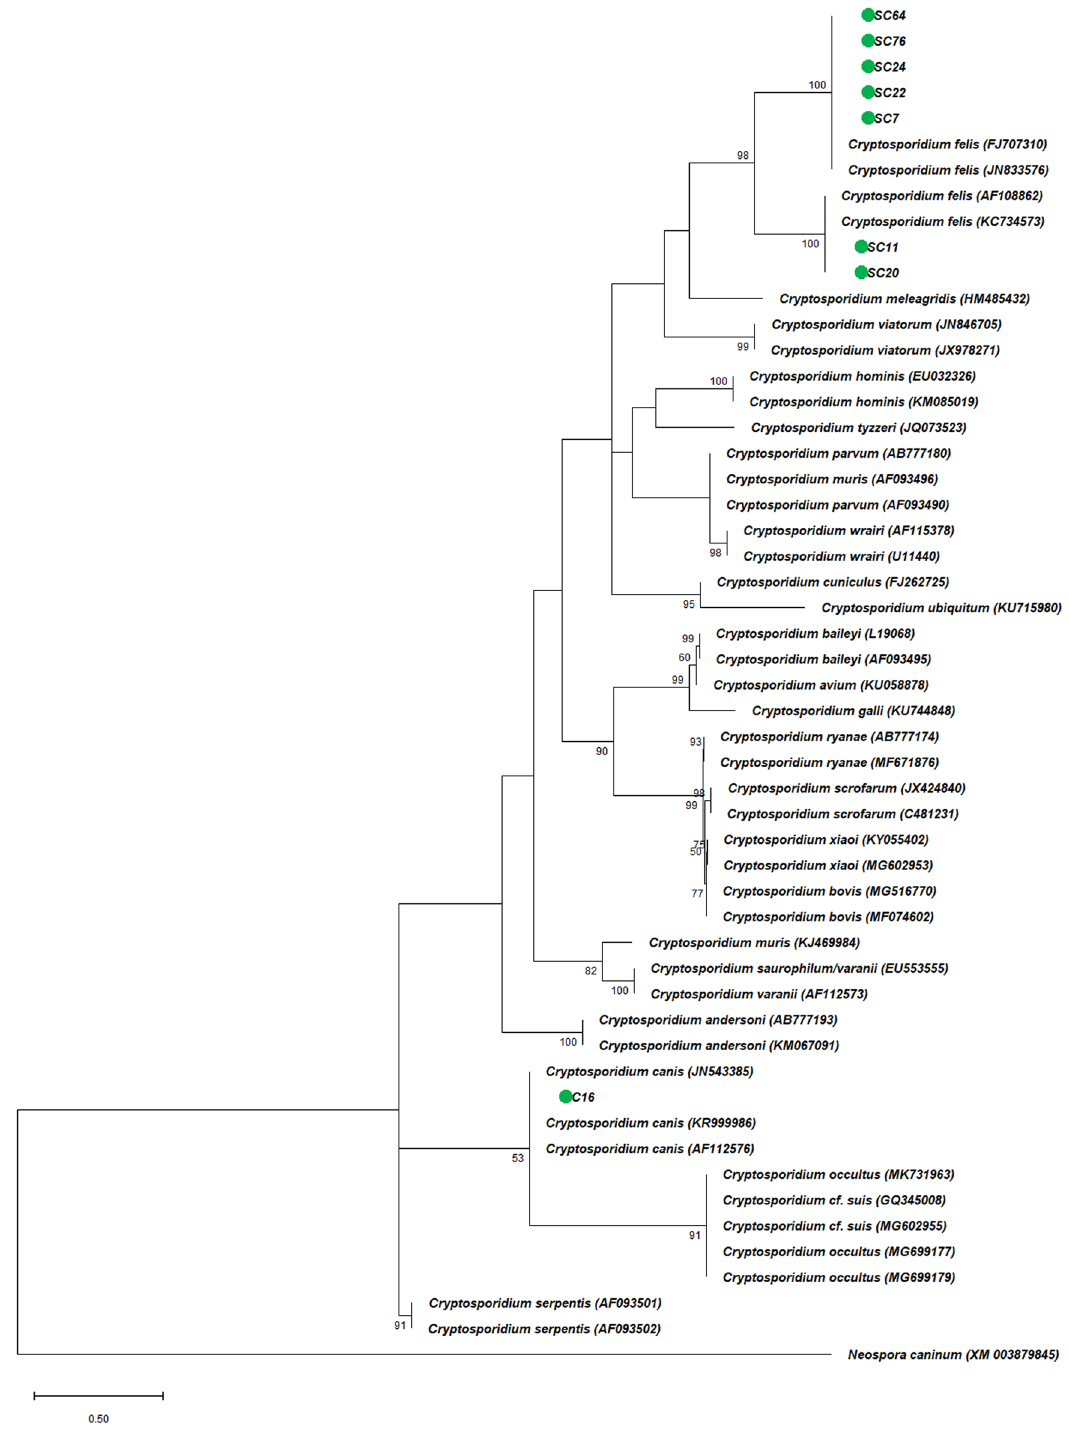
Figure 1. The phylogram of Cryptosporidium spp. was inferred based on the nucleotide sequences of SSU rRNA gene. The evolutionary relationship of Cryptosporidium spp. was constructed by the Maximum Likelihood method and Kimura 2-parameter model, based on the nucleotide sequences of SSU rRNA gene of C. felis and C. canis isolated from stray cats [SC] and household cats [C] in this study (green circles) compared with nucleotide sequences of Cryptosporidium species retrieved from GenBank, with Neospora caninum (XM_003879845) as outgroup. Bootstrap values obtained from 1000 replicates are indicated on branches in percentage; only bootstrap values > 50% are displayed. Evolutionary analyses were conducted in MEGA